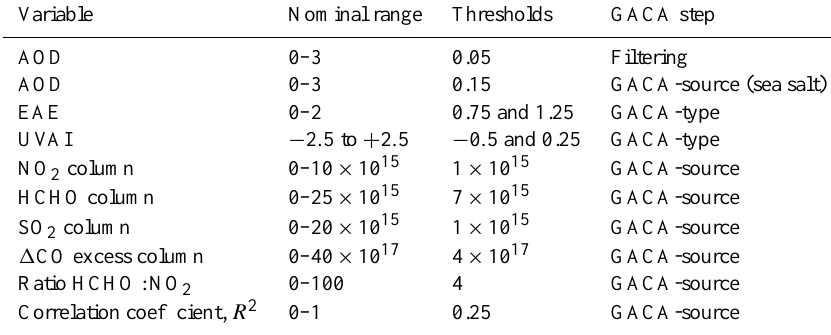
Table 3. Thresholds used in GACA. Variables are unitless except for the trace gas (excess) VCDs (given in moleccm − 2